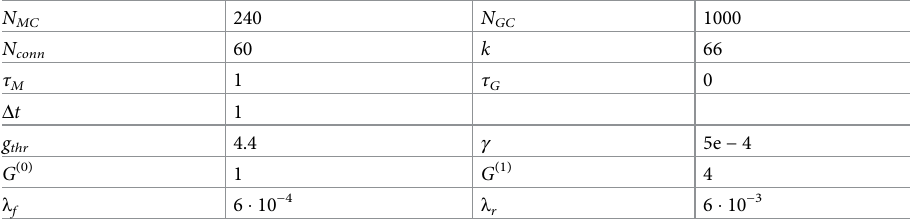
Table 1. Parameters used in the simulations of the model (unless stated